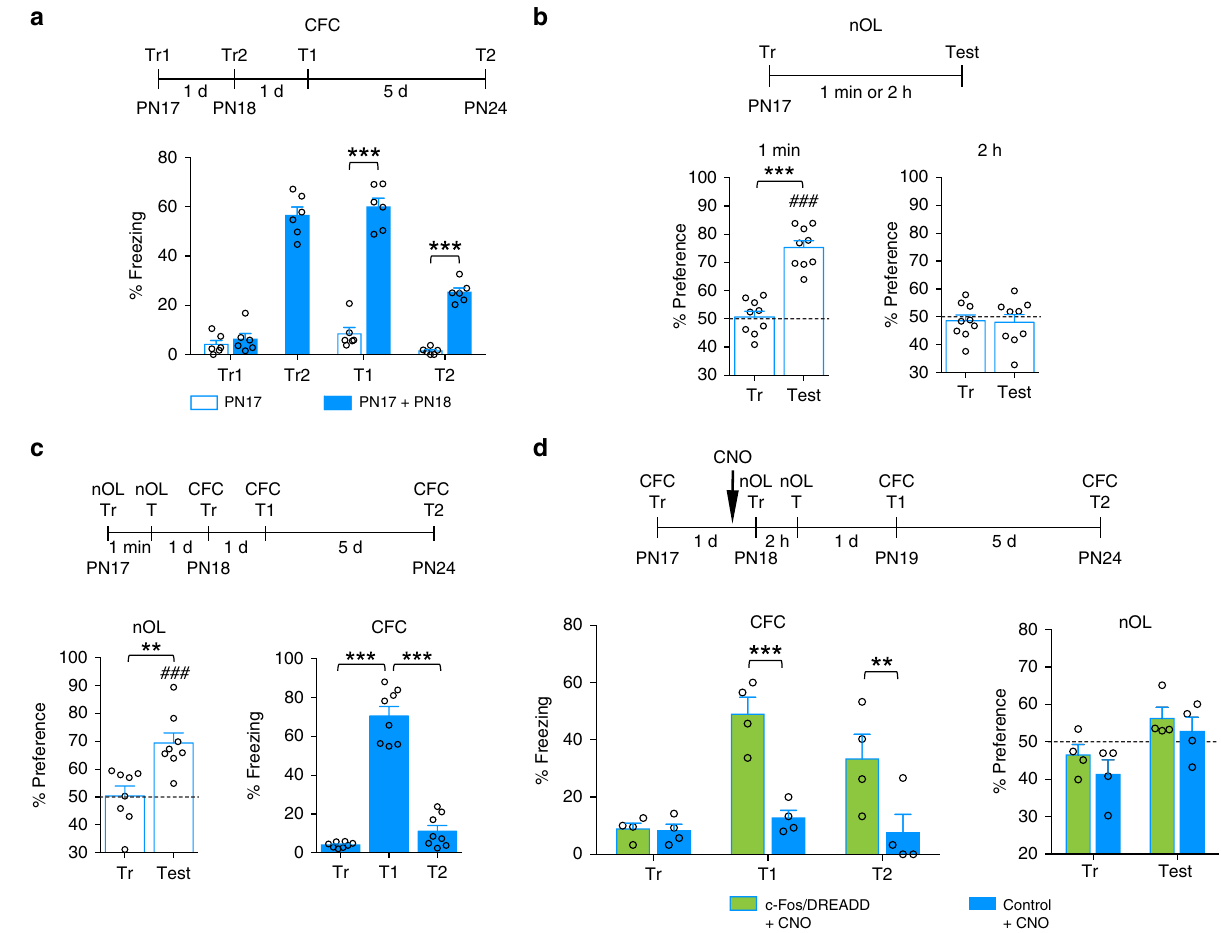
Fig. 8 Acquisition of functional competence in mice is learning-selective. a Mice ( n = 6 per group) received two CFC trainings, one at PN17 and the second at PN18. They were tested 1 day after the last training (T1) and again 5 days later (T2). *** P < 0.001 (two-way RM ANOVA followed by Bonferroni ’ s multiple comparisons test). b Mice ( n = 9 per retention time) were trained in nOL at PN17 and tested 1 min or 2 h after training. *** P < 0.001 (two-tailed paired Student ’ s t test). ### P < 0.001 signi fi cance for one-sample t tests comparing each group to chance performance (50%). c Mice ( n = 8) were